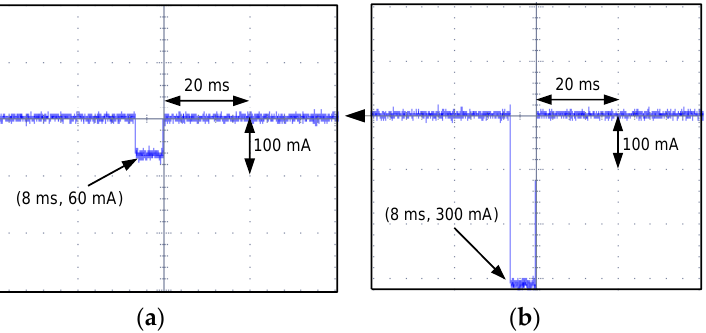
Figure 24. Oscillograms of the DC current flow during the tripping test of the A-type RCD (RCD30_7). Suddenly applied DC current of the following values: ( a ) 60 mA; ( b ) 300 mA.